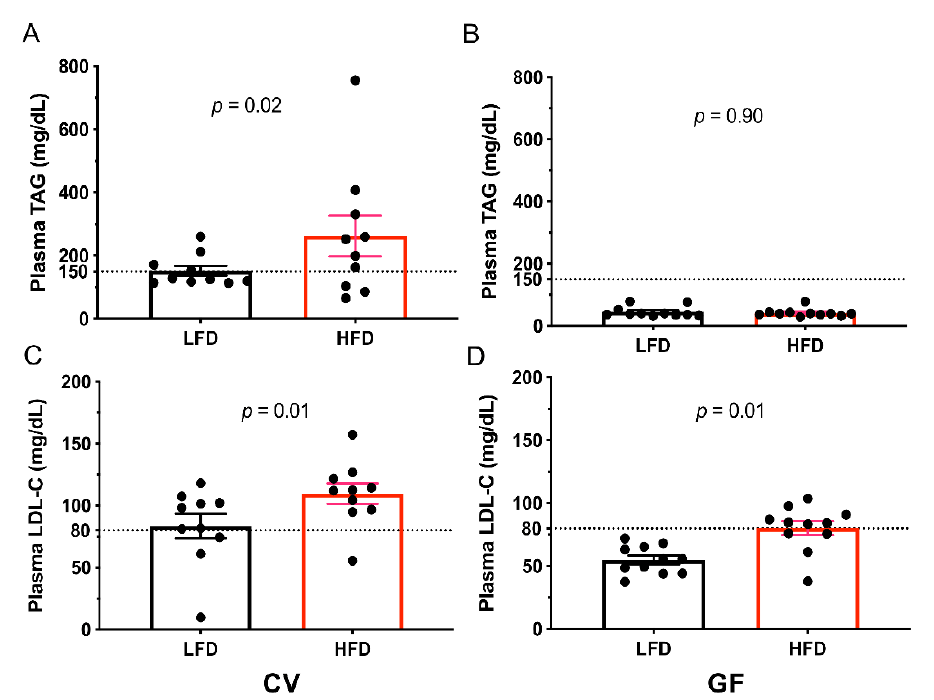
Figure 5. The HFD increases plasma TAG in only CV mice and insulin levels in both CV and GF mice. Quantification of (panels A , B ) plasma triacylglycerol (TAG) and (panels C , D ) LDL-cholesterol (LDL-C) concentrations. The values for individual mice are shown as dots (CV, n = 10; GF, n = 11), the means as bars, and horizontal lines indicate the standard error of the mean ( ± SEM). The dotted horizontal lines indicate elevated concentrations. Abbreviations: CV, conventional; GF, germ-free; HFD, high fat diet; LFD, low fat diet; TAG, triacylglycerol. Table 5. Effect of the low- and high-fat diets on plasma lipid concentrations in conventional and germ- free male Tac:SW mice.